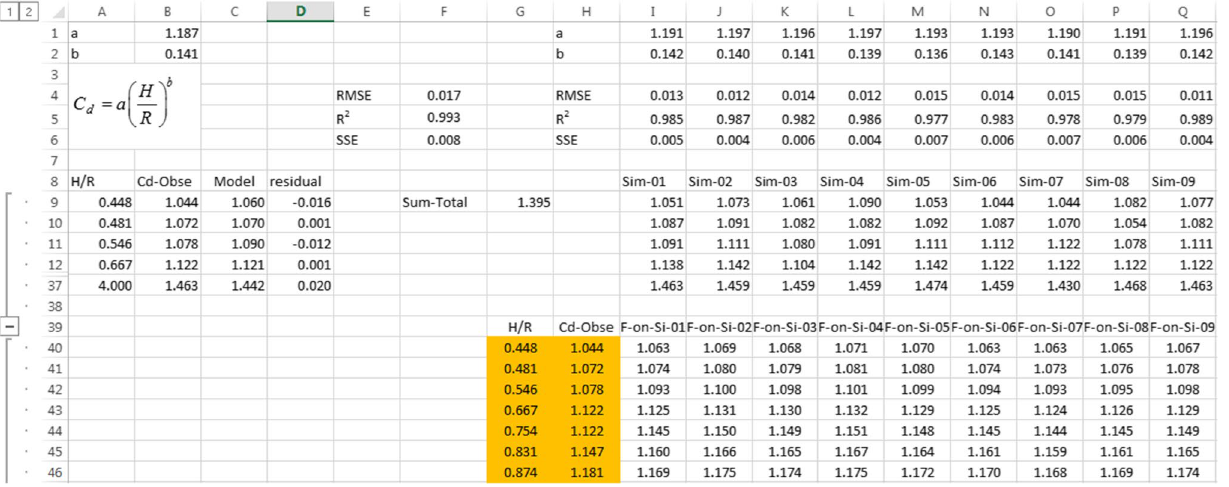
Fig. 4 The process of uncertainty analysis of Cd based on the Bootstrap method of circular crested weirs